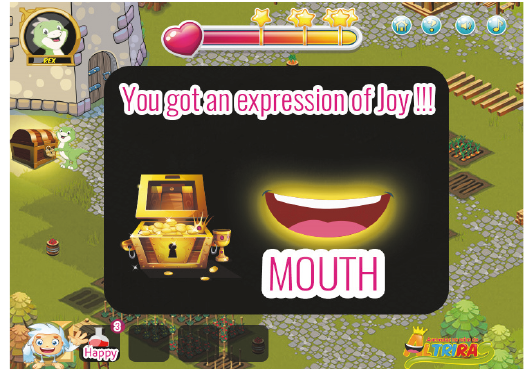
Figure 13: Opening of the box and receiving a facial expression.